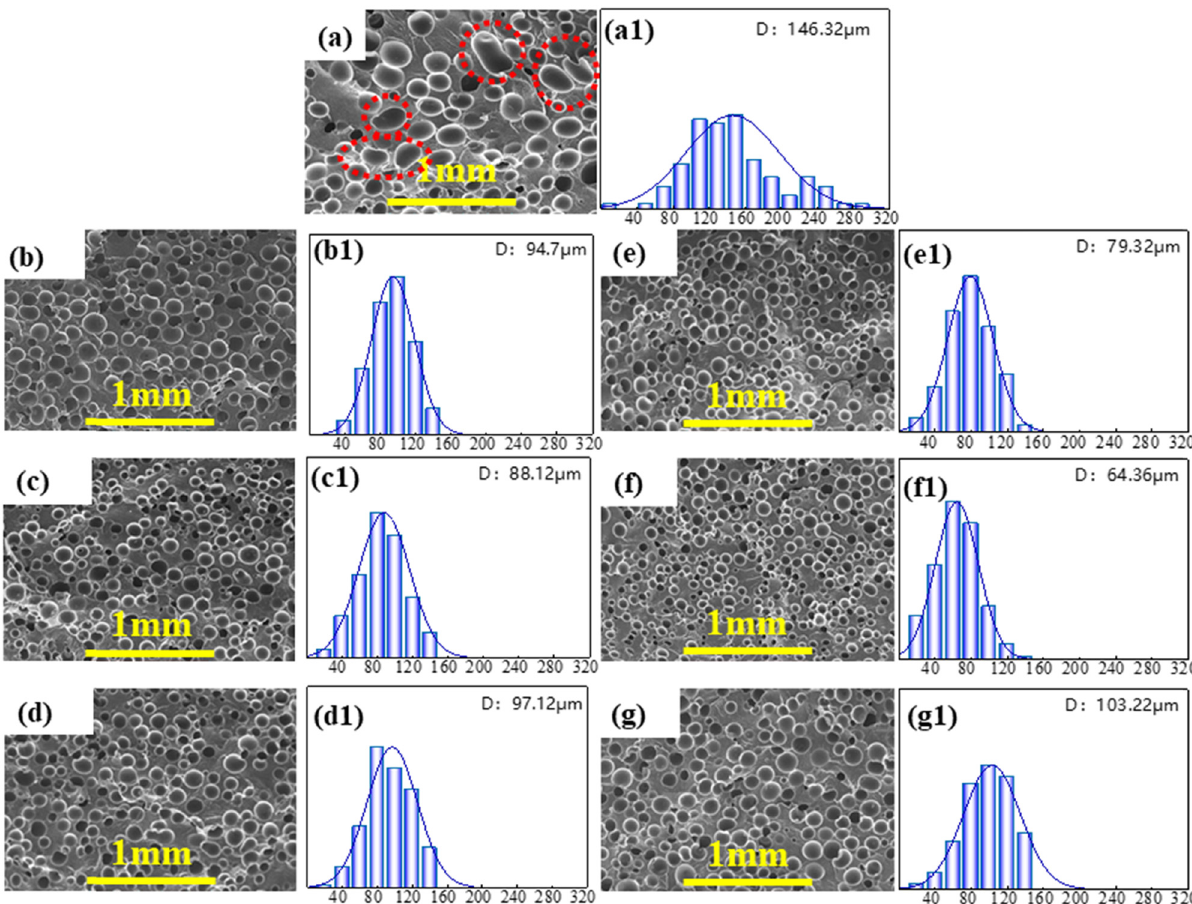
Figure 6: SEM images of microcellular foams and histogram of statistical distribution of microcell sizes in PA6 microcellular foams with di ff erent chain extender: pure PA6 ( a,a1 ) , PA6 - ZeMac 0.3 ( b,b1 ) , PA6 - ZeMac 0.5 ( c,c1 ) , PA6 - ZeMac 0.7 ( d,d1 ) , PA6 - TGIC 0.3 ( e,e1 ) , PA6 - TGIC 0.5 ( f,f1 ) , PA6 - TGIC 0.7 ( g,g1 )